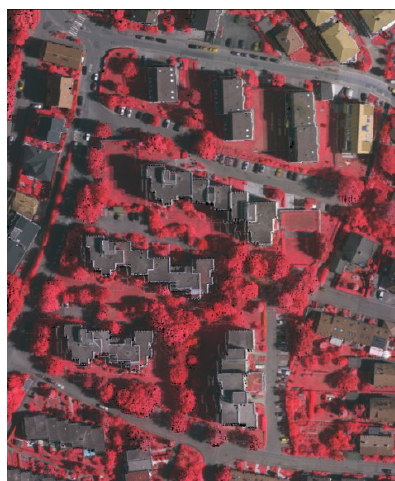
Figure 9. Generated true ortho photo for the third area